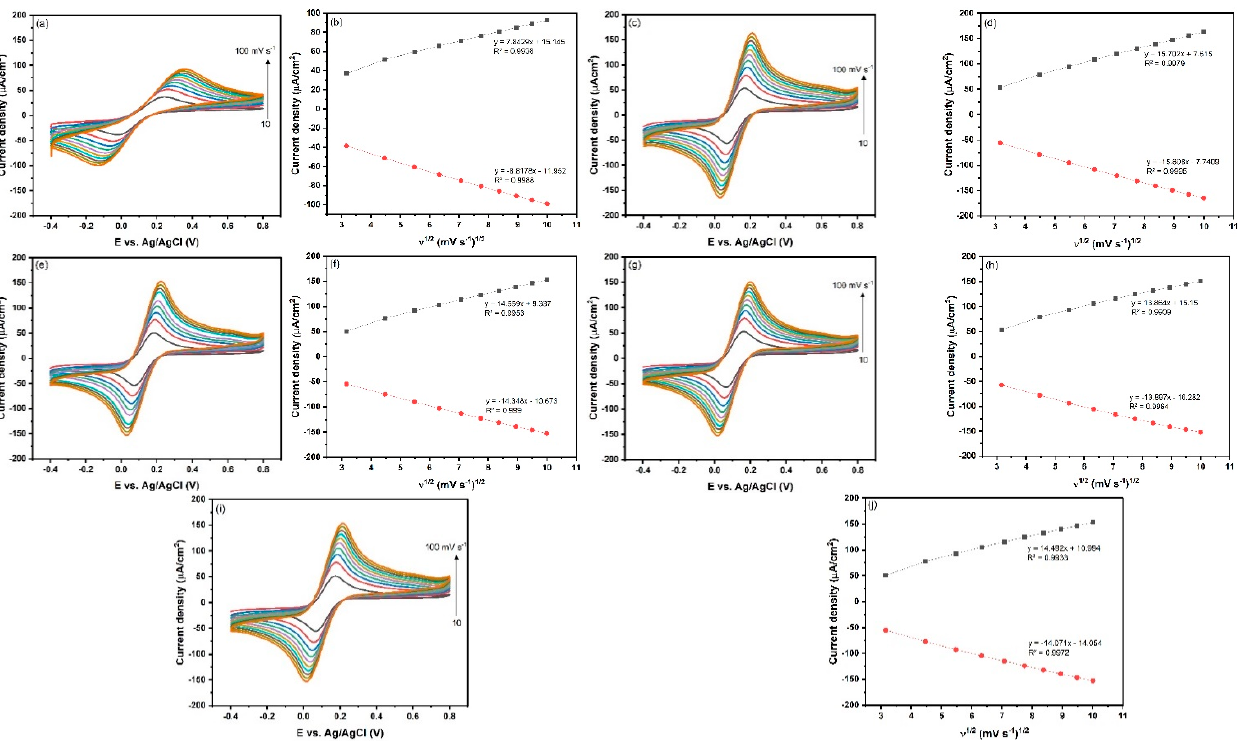
Figure 4. CV response of various scan rates from 10 to 100 mV s − 1 , ( a ) bare GCE, ( c ) 50AuNPs@MWCNTs, ( e ) 50AuNPs@VGCFs, ( g ) 50AuNPs@KS4, and ( i ) 50AuNPs@SP. Correspond- ing linear line plots of redox peak current density and the square root of scan rate (V s − 1 ), ( b ) bare GCE, ( d ) 50AuNPs@MWCNTs, ( f ) 50AuNPs@VGCFs, ( h ) 50AuNPs@KS4 and ( j ) 50AuNPs@SP. All measurement were studied in containing 5 mM [Fe(CN) ₆ ] 3 − / [Fe(CN) ₆ ] 4 − /0.1 M KCl (0.1 X PBS). Table 1. The electrochemical surface area of four different